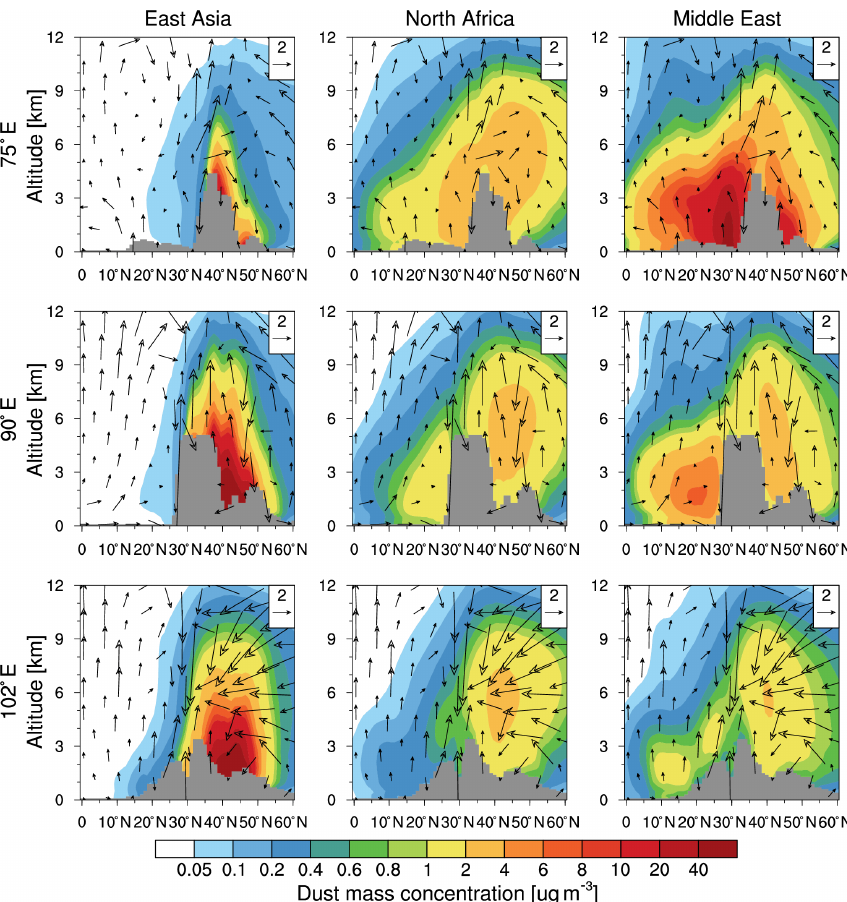
Figure 6. Vertical cross sections of meridional circulation (in meters per second and a scale factor of 300 is applied for vertical wind) and zonal dust mass concentration (in micrograms per cubic meter) emitted from East Asia, North Africa, and the Middle East at 75, 90, and 102 ◦